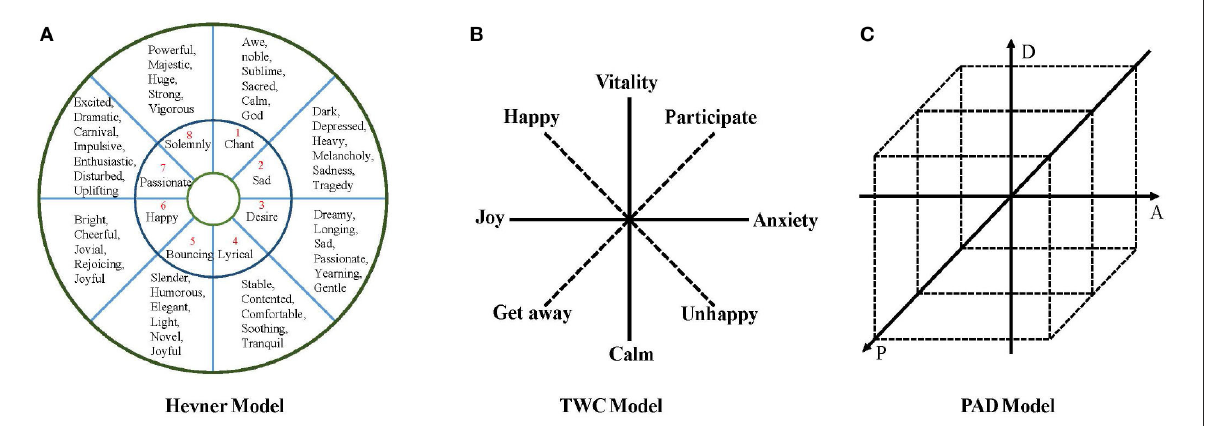
FIGURE2 The common MER model. (A) Hevner model. (B) TWC model. (C) PAD